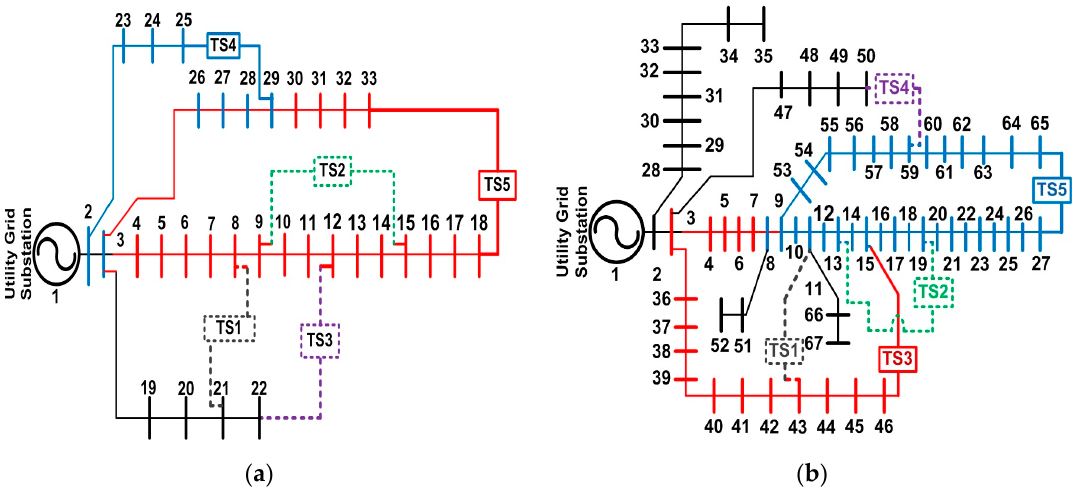
Figure 3. ( a ) 33-Bus Mesh Distribution System; ( b ) 69-Bus Mesh Distribution System [35,50]. Figure 3. ( a ) 33-bus Mesh Distribution System; ( b ) 69-bus Mesh Distribution System